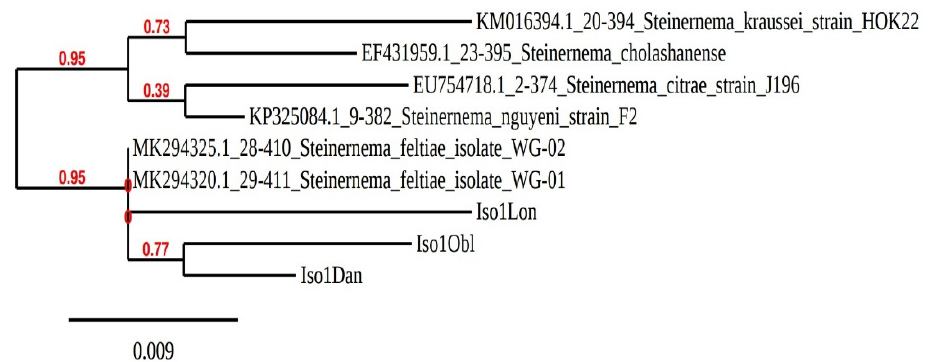
Table 3. Biological activity of Steinernema feltiae isolates (mean values).